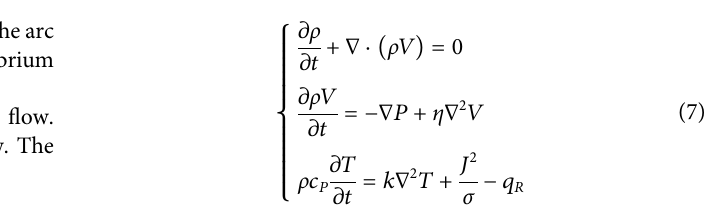
Frontiers in Energy Research |